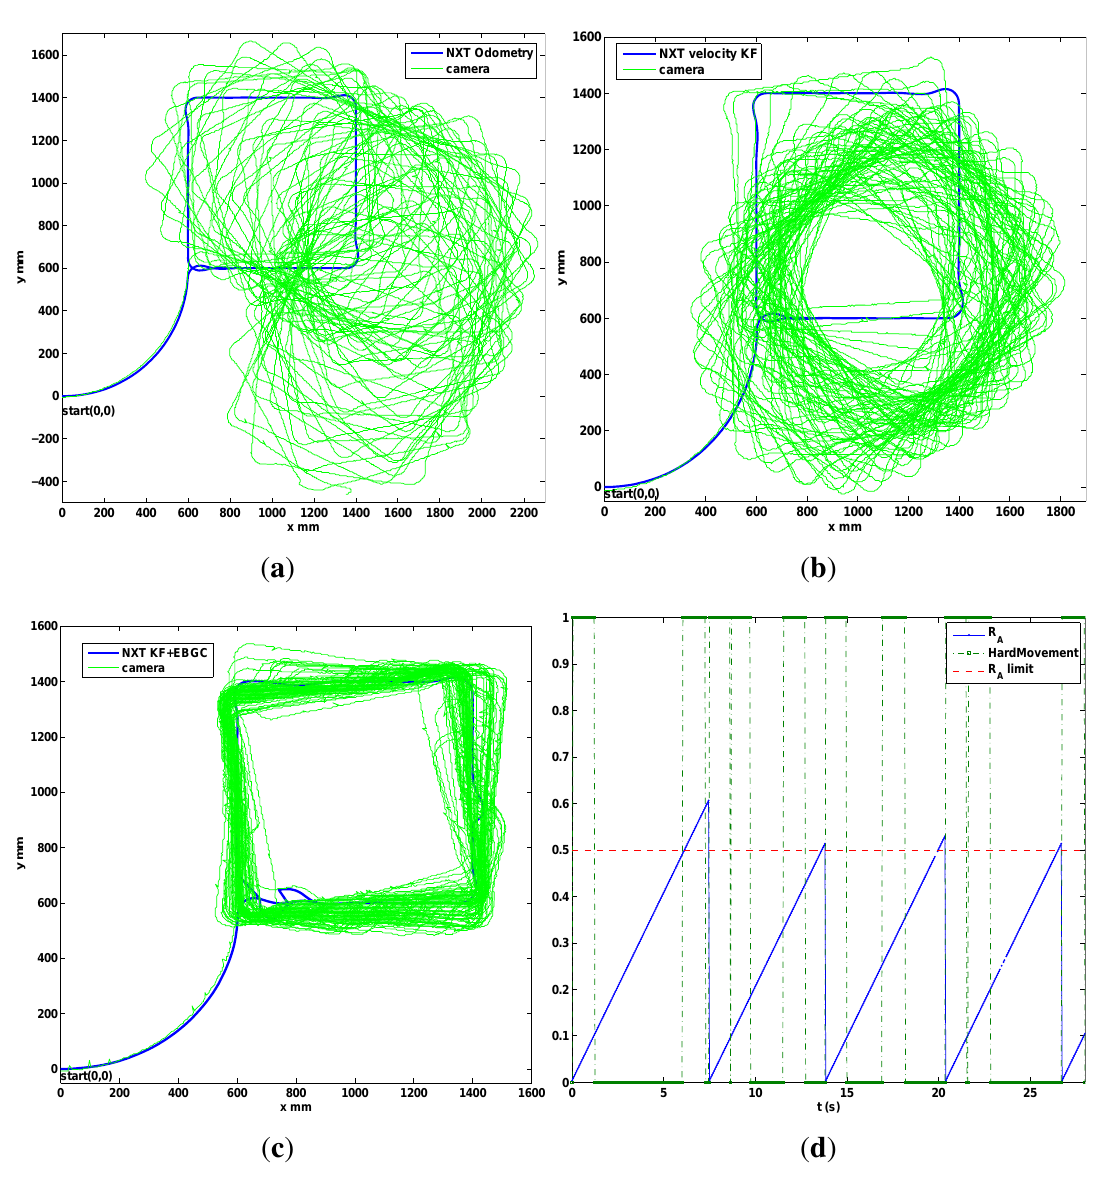
Figure 9. 30 min run, methods comparison, differential robot. ( a ) Odometry from encoders; ( b ) Algorithm 2 without L ( d ) R evolution. A